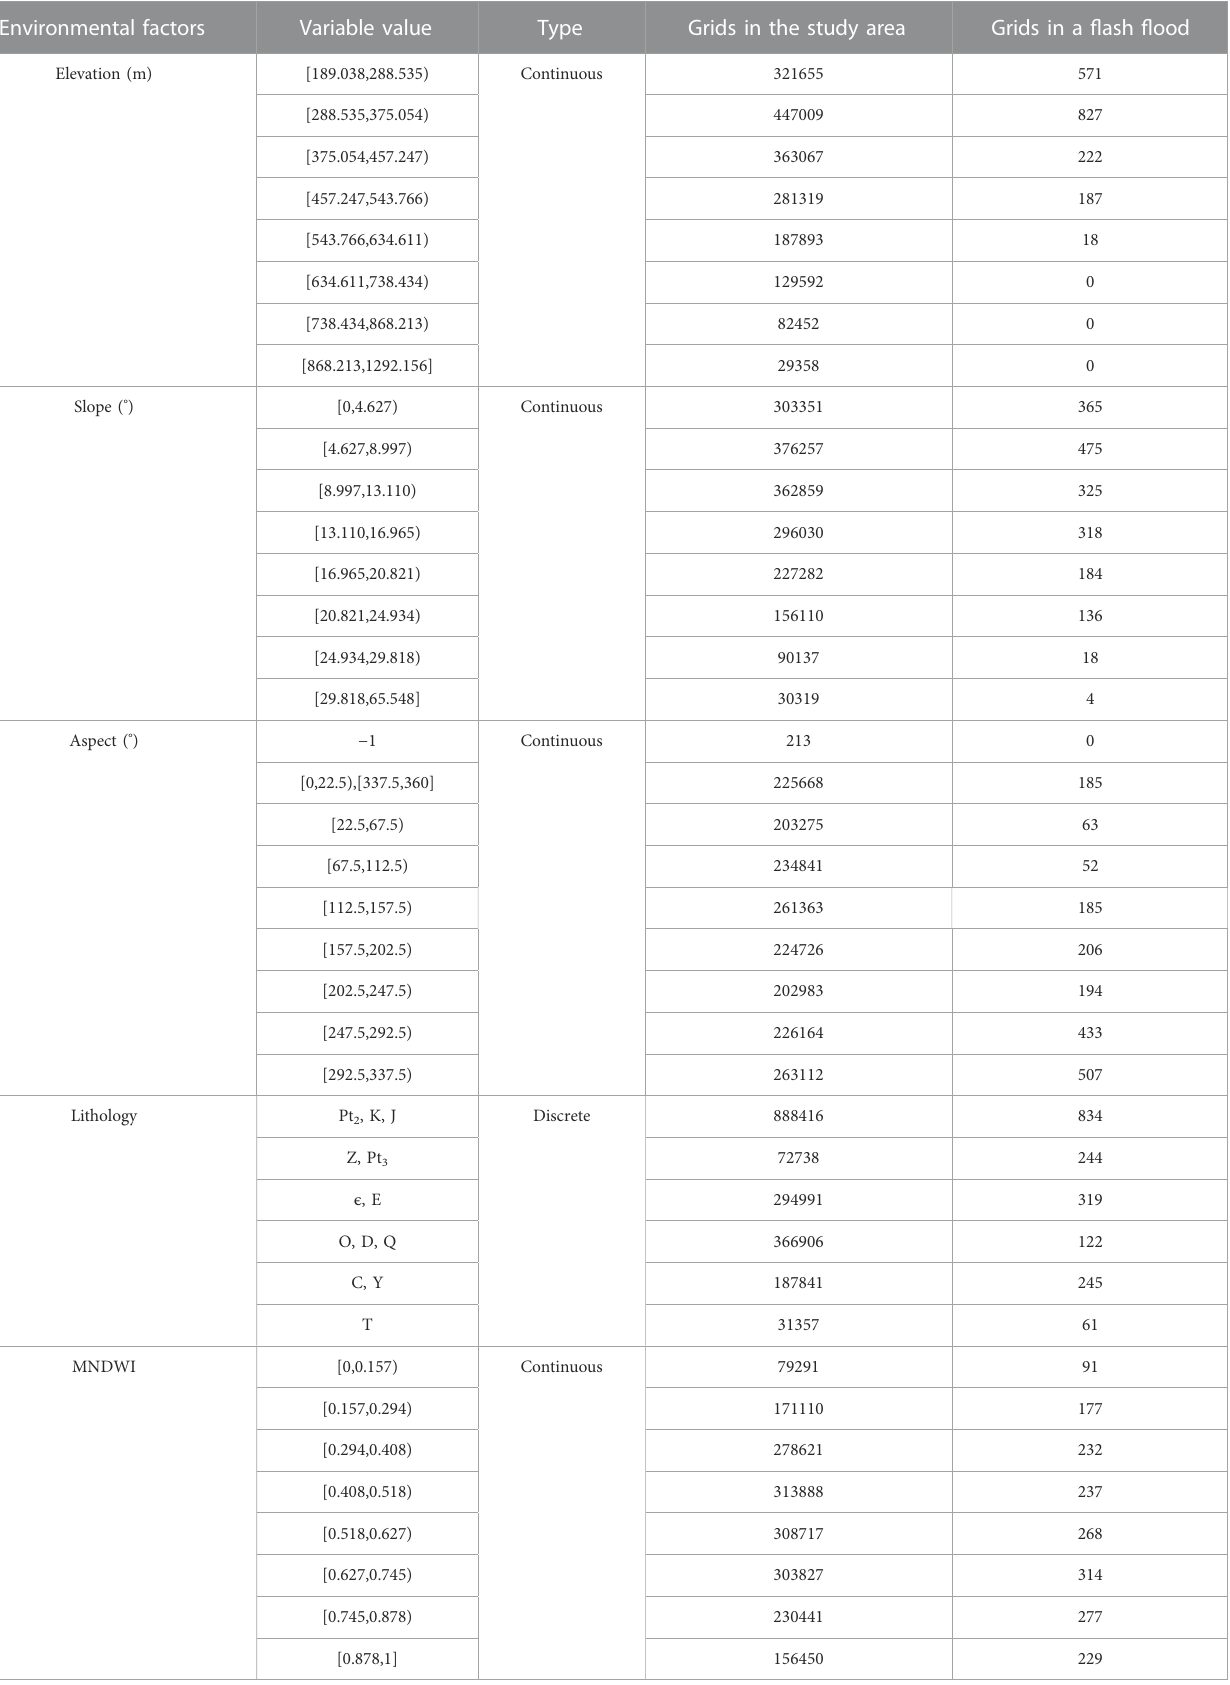
TABLE 1 Original data of each basic environmental